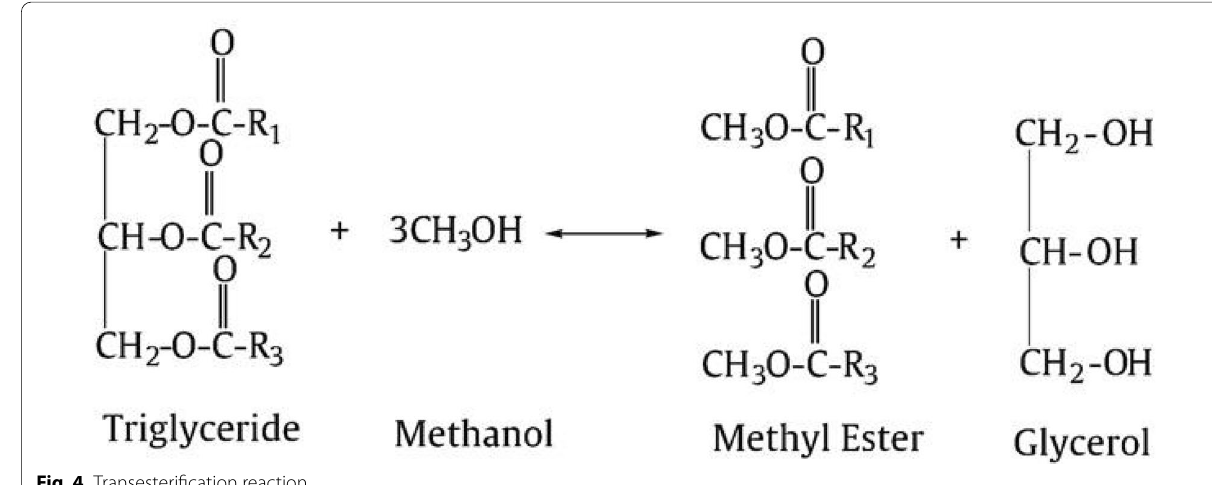
Fig. 4 Transesterification reaction